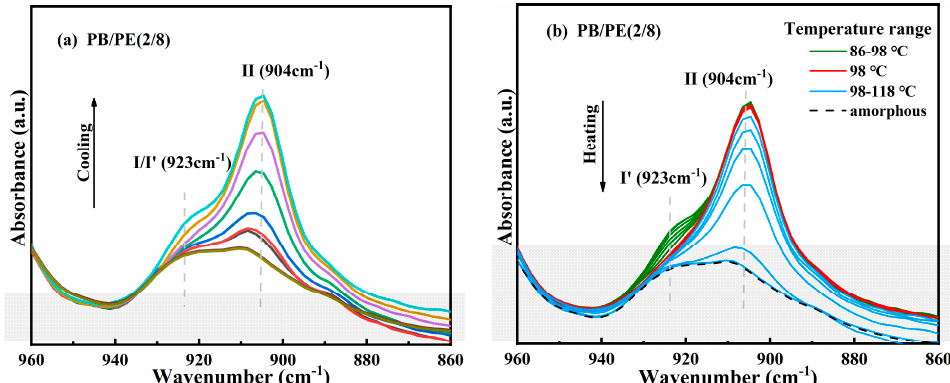
Figure 4. In situ FTIR spectra obtained within ( a ) cooling and ( b ) heating processes of PB/PE(2/8).